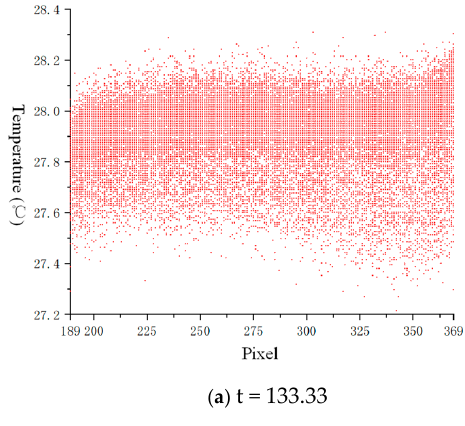
Figure 7. ( a ) t = 133.33